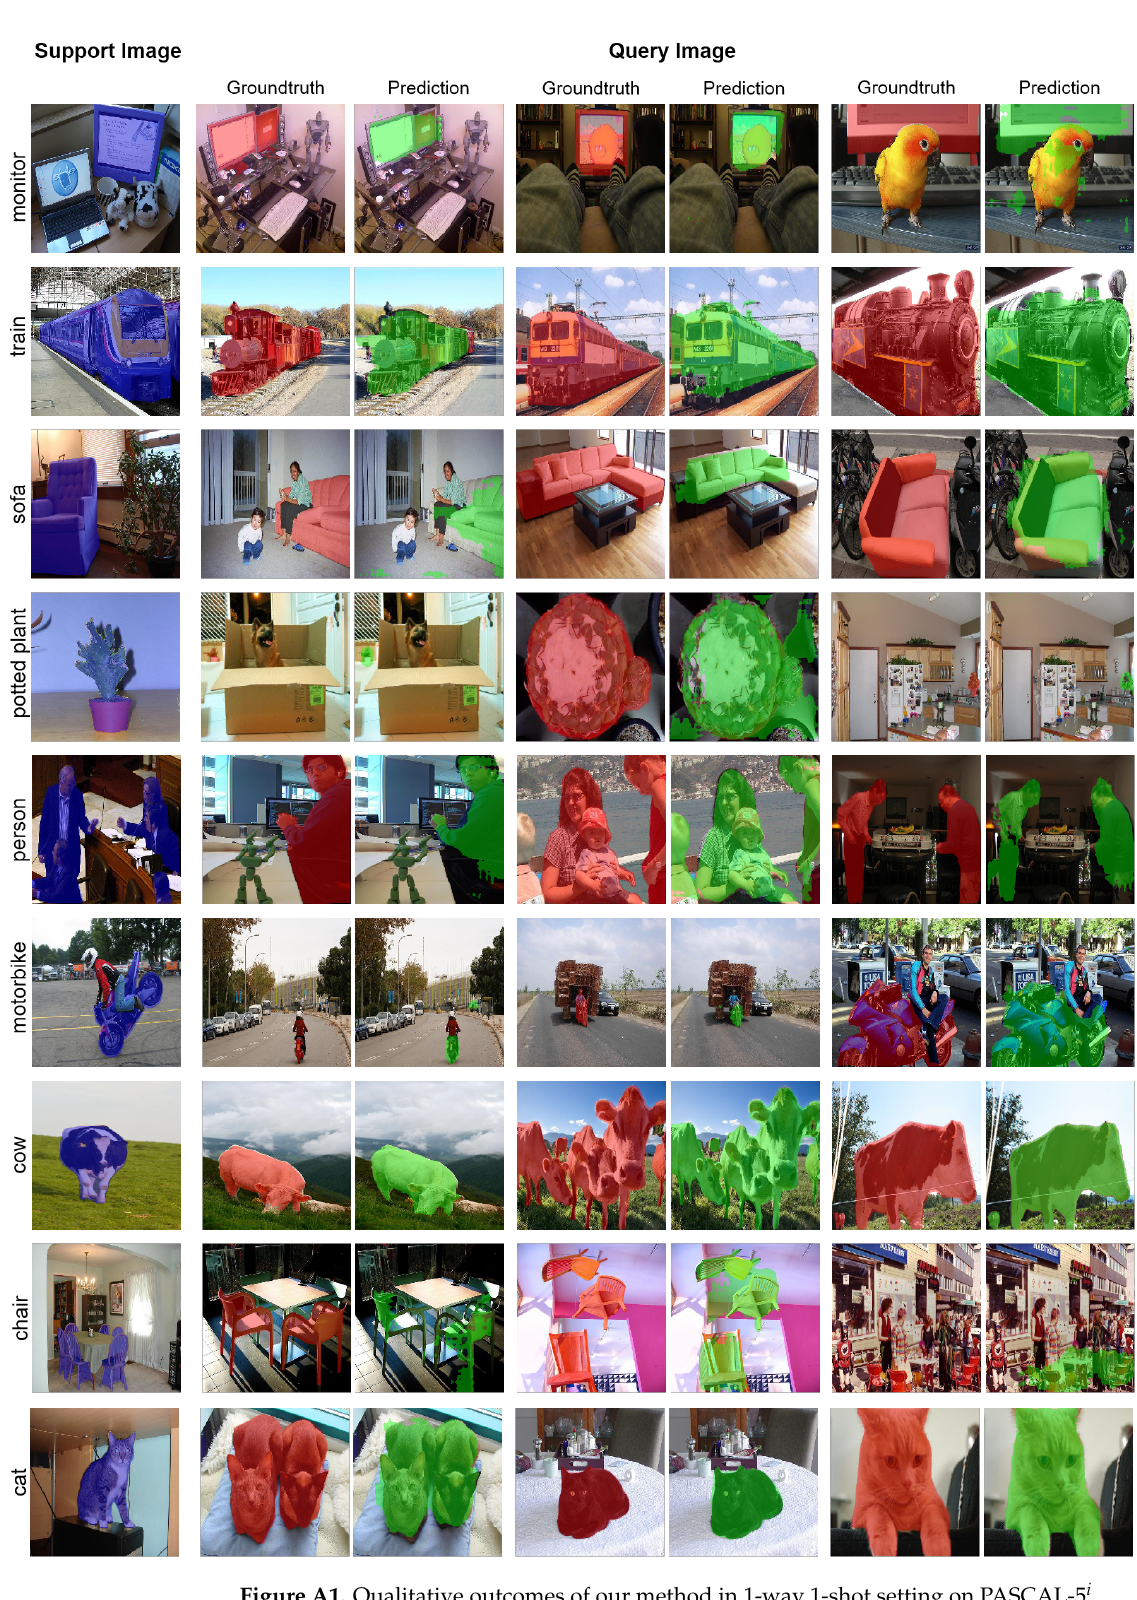
Figure A1. Qualitative outcomes of our method in 1-way 1-shot setting on PASCAL-5 i